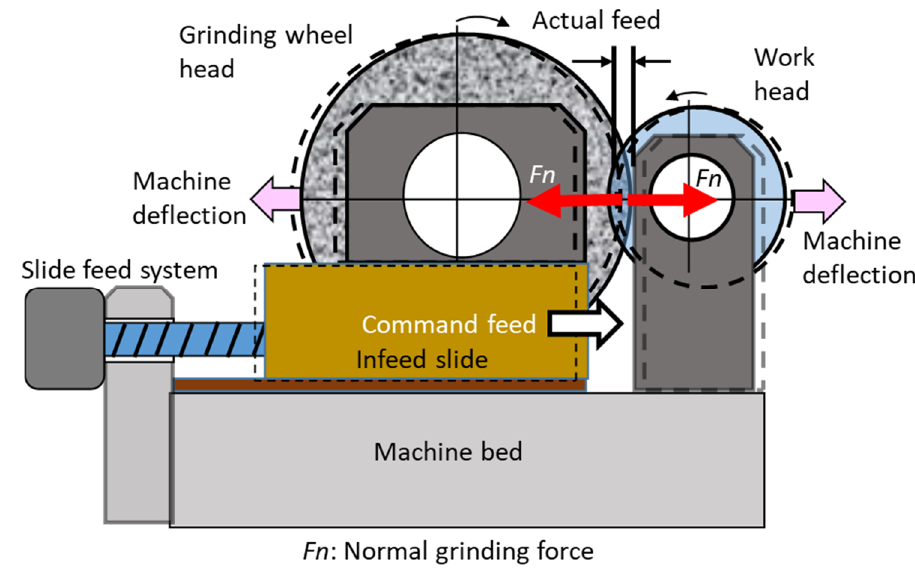
Figure 7. Schematic of cylindrical grinding machine.